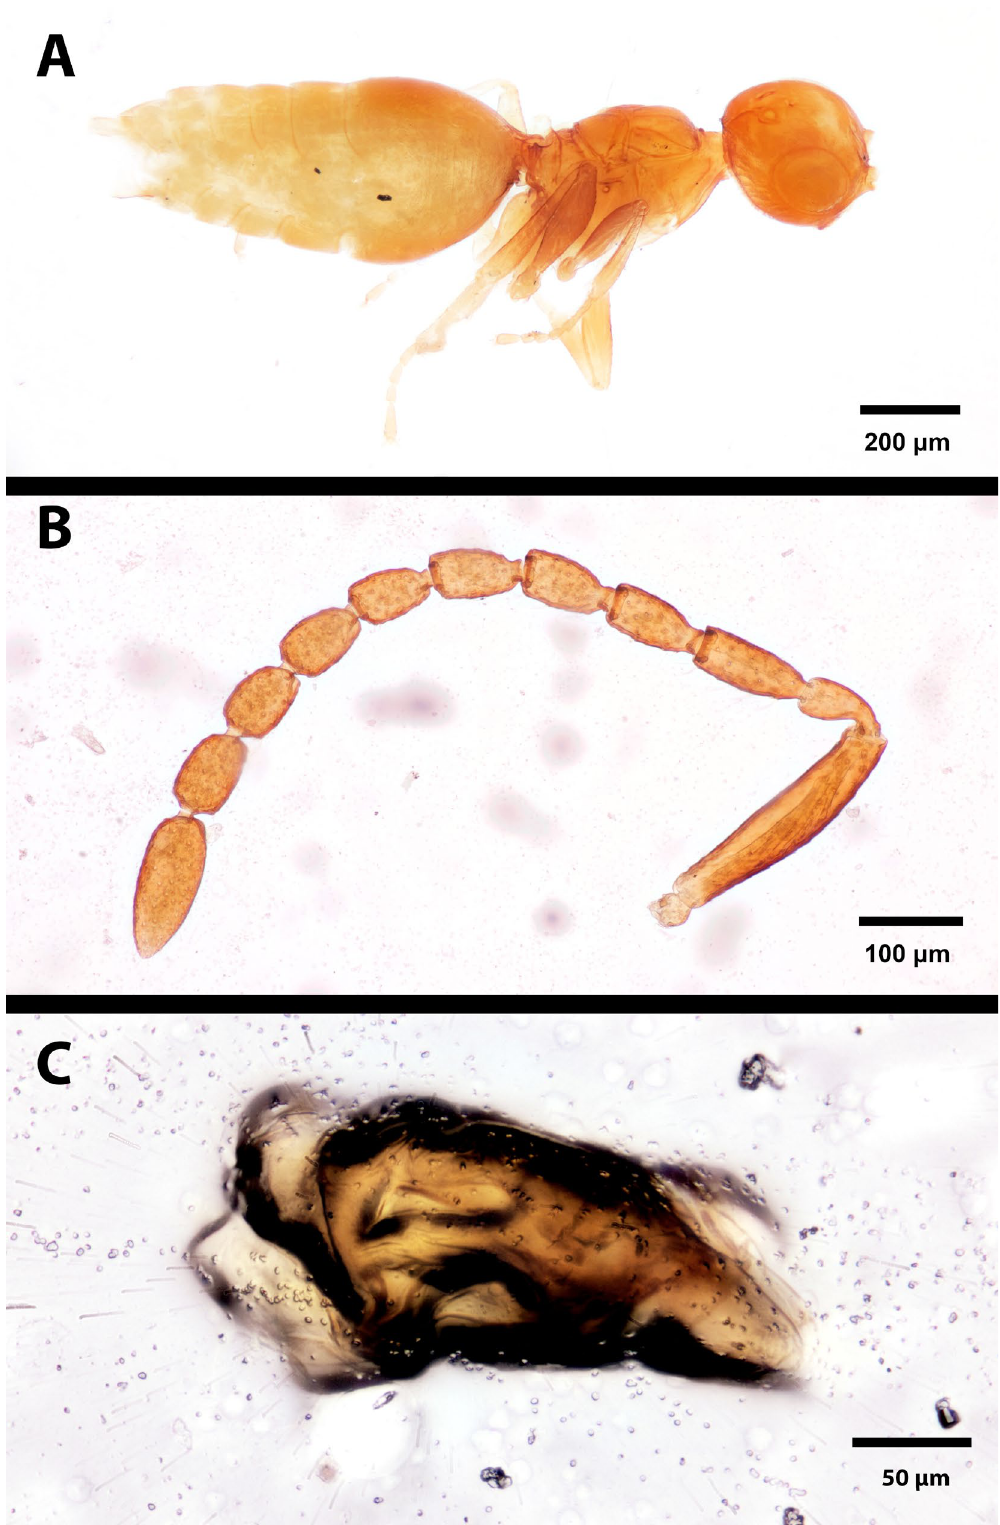
Fig. 22. Conostigmus pedester Kieffer, 1913, allolectotype, ♂. A . Lateral habitus (MNhN EY25353). B . Left antenna (MNhN EY22450). C . Genitalia, lateral view, in poor condition (MNhN